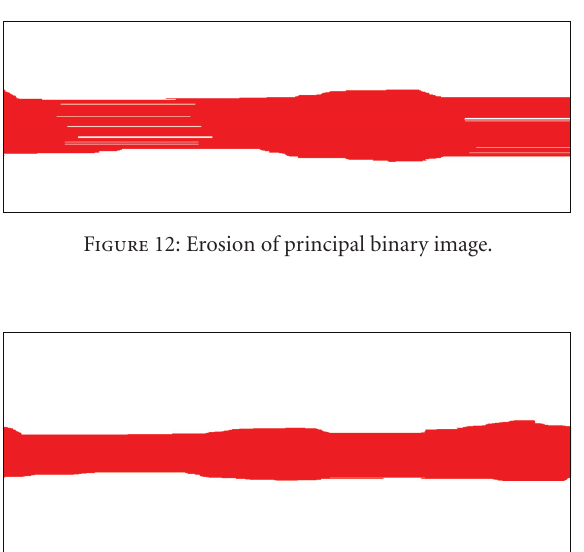
Figure 13: Core flow line region = α -erosion of principal binary image with α = 0.9.